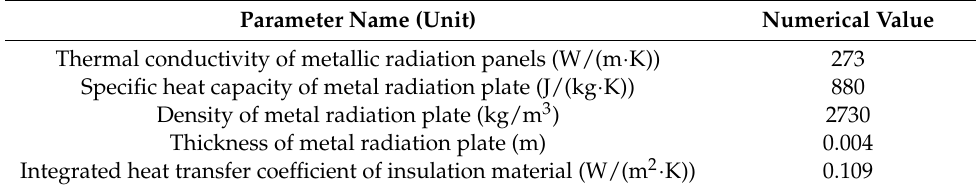
Table 1. Thermal parameters of thermoelectric radiation panels. Parameter Name